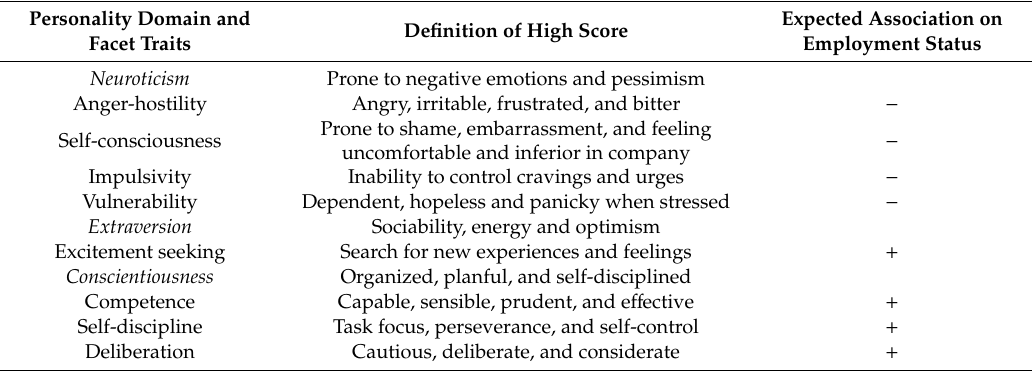
Table 1. A priori hypotheses about the association between personality and